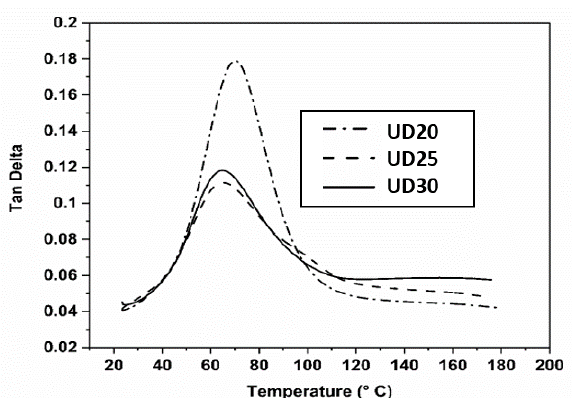
Figure 9. Tan Delta curves of DMA-tested UD composite specimens at a temperature range from 20 °C to 180 °C.